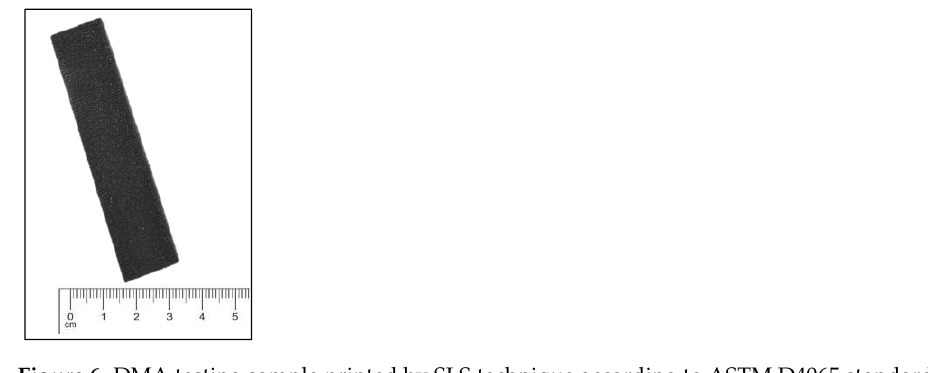
Figure 6. DMA testing sample printed by SLS technique according to ASTM D4065 standard.